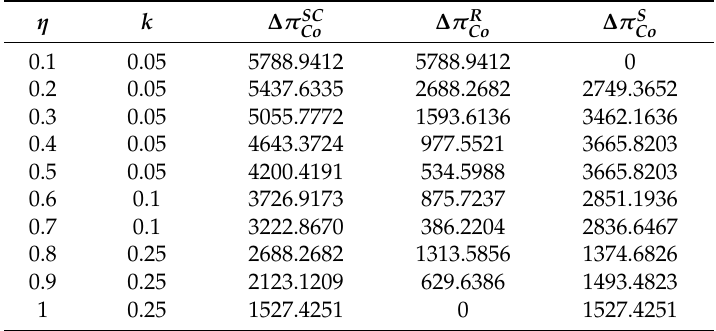
Table 1. Impact of the risk aversion attitude on the profits of the supply chain partners.